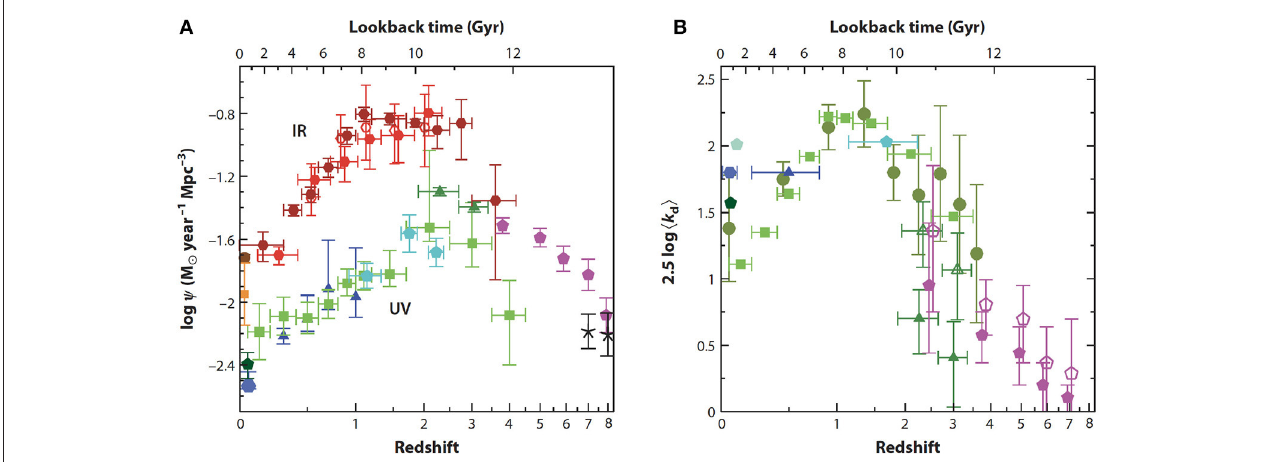
FIGURE 3 | The observed star formation rate density in galaxies at different redshifts (Credit to Madau and Dickinson, 2014, their Figure 8). (A) SFR densities in the FUV (uncorrected for dust attenuation) and in the FIR. (B) Mean dust attenuation in magnitudes as a function of redshift.